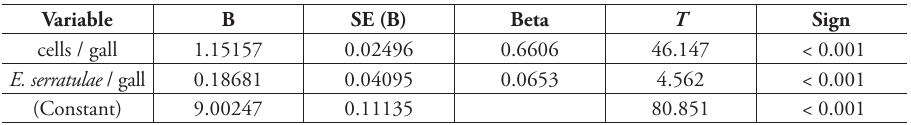
Table 1. The effect of cells / gall and E. serratulae larvae / gall on gall diameter. Multiple regression: de- pendent variable: gall diameter, N = 2.733, multiple R = 0.67115, adjusted R² = 0.45024, SE = 3.02533.